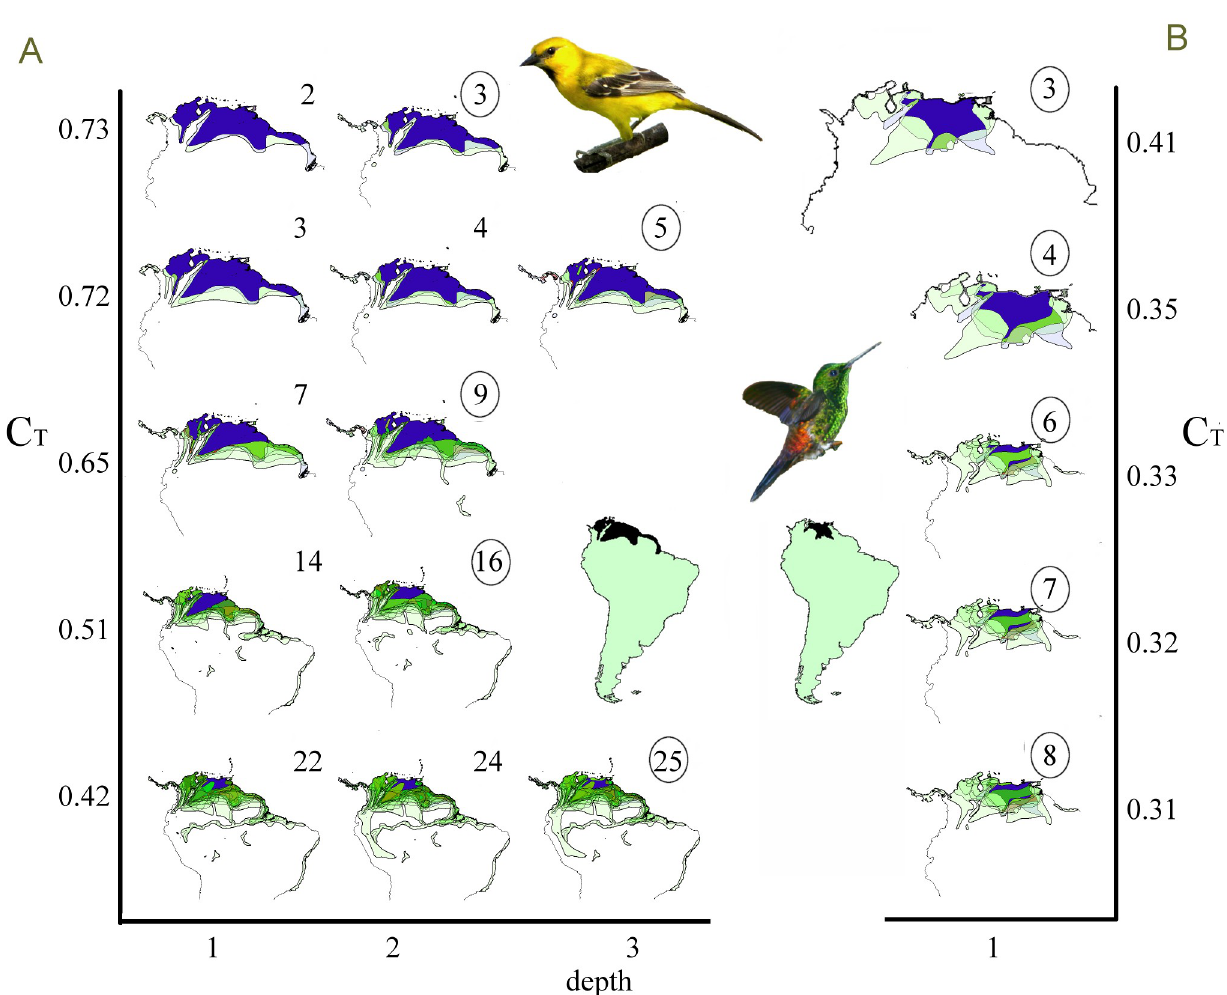
Fig 4. Congruence diagrams illustrating the whole set of partial chorotypes of Icterus nigrogularis and Amazilia tobaci bird species. A didactic representation of spatial congruence relationships depicts congruence threshold (C T , y - axis, free scale) and depth (x-axis). (A) Icterus nigrogularis (Yellow Oriole) and (B) Amazilia tobaci (Copper-rumped Hummingbird). For each C T and depth, ranges (light-green) are overlaid; number of species in each group are shown for each round at each depth. Circles depict the closed lists (partial chorotypes) at the end of each round of threshold analysis. The common area is shown in dark-blue. South America insets show reference species ranges as black. Grouped species and synonymous patterns are listed in S3 and S4 Tables, respectively. Geographic scales differ because maps are zoomed out to accommodate successively larger lists. Credit: images of I . nigrogularis and A . tobaci adapted from Wikimedia Commons under Attribution-Share Alike 2.0 Generic license (creativecommons.org/licenses/by/2.0/ deed.en).